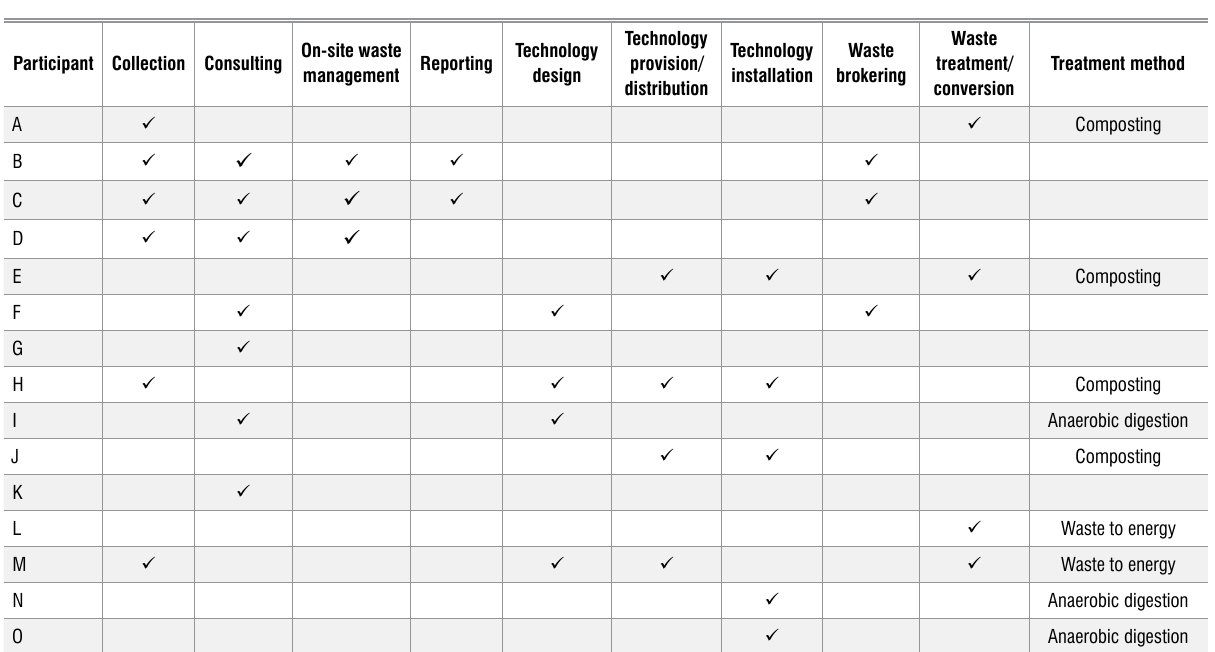
Participants’ self-reported organic waste related activities Participant Collection Consulting